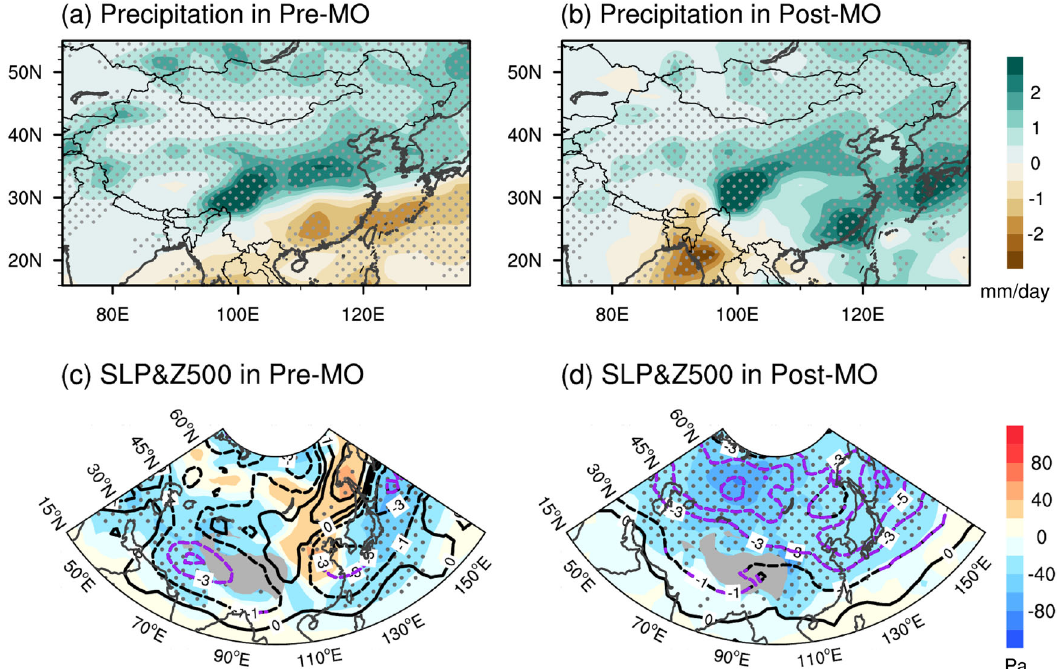
Fig. 6 Projected changes in precipitation and synoptic disturbances in CanESM5. Differences between the historical run (1979 – 2014) and the SSP5-85 run (2065 – 2100) of CanESM5 in a , b precipitation (mm/day) and c , d the RMS of 2 – 8-day fi ltered SLP (shading, Pa) and 500-hPa geopotential height (contours, m) in (left) pre-MO and (right) post-MO periods. Stippled areas in a and b are signi fi cant at the 0.01 level. Dotted areas and purple contours in c and d are signi fi cant at the 0.05